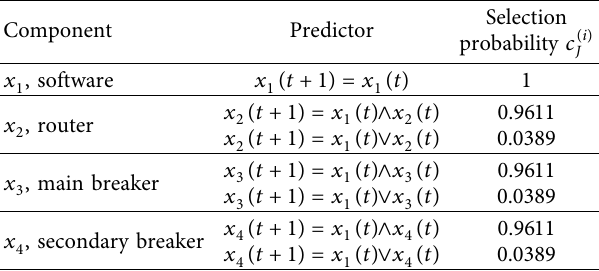
Table 1: IPR failure mode classification and their corresponding states [4]. Category Type Fault Normal operation Failure Fault On active signal (AS, switching event), On AS, the IPR does not On AS, the IPR does not On AS, the IPR works the IPR works as intended. On inactive work as intended. On IS, work as intended. On IS, Description as intended. On IS, the signal (IS, nonswitching event), IPR does the IPR does not work as the IPR works as IPR works as intended. not work as intended. intended. intended. States Table 2: Predictors and selection probability, IPR PBN. Component Predictor